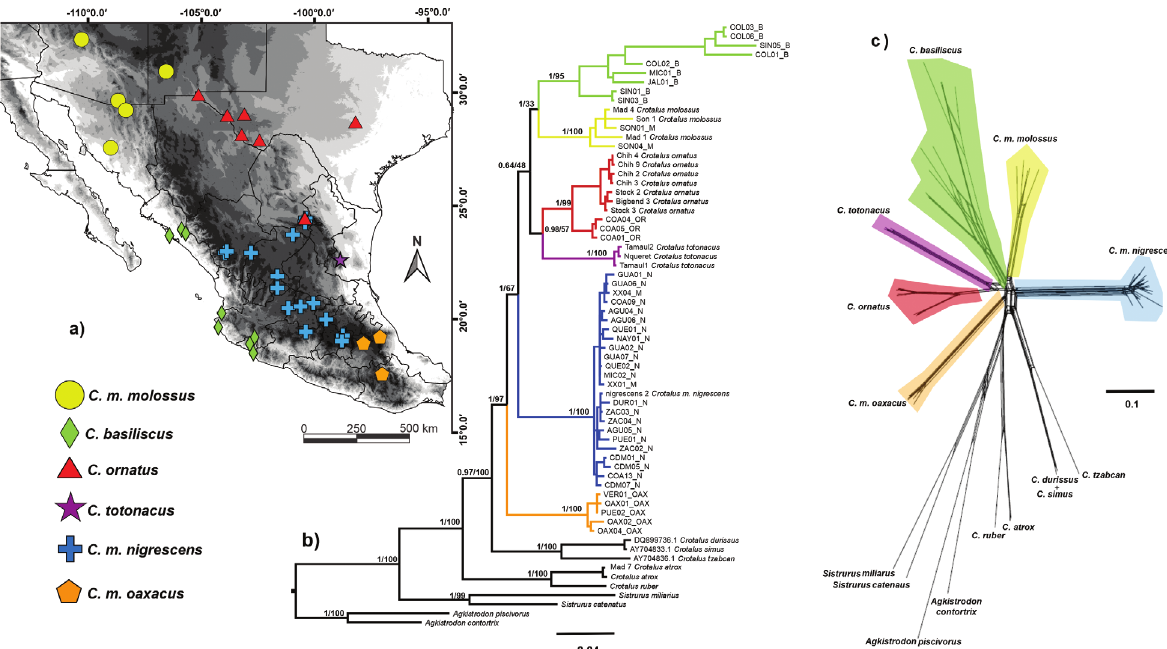
Figure 2. a. Geographical distribution of the six clades indicated over the topography of North America; b. Phylogenetic inference based on the 3-mtDNA dataset of black-tailed rattlesnakes inferred by Bayesian inference (BI). Nodal support indicates posterior probabilities (BI) above and bootstrap of Maximum likelihood (ML) values below diagonal; c. Neighbor-Net analysis inferred with the SplitsTree